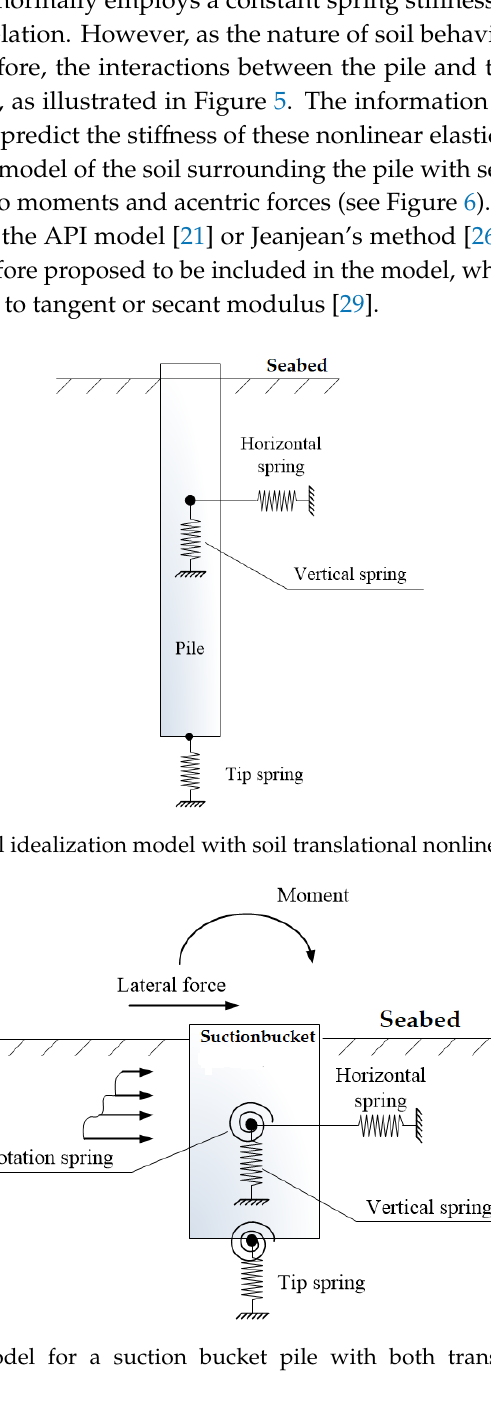
(8) In reality, the movement of soil is difficult to predict, and figuring out a closed-form solution to such a problem is extremely complicated. In this study, a numerical solution for soil movement was therefore obtained by controlling the iterations and preventing the overshoot value for soil stiffness by using the utilized value i N :